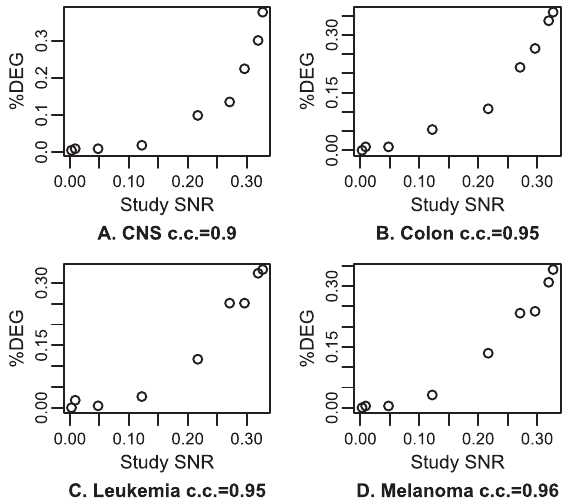
Figure 2. Effect of increasing levels of noise on study SNR and statistical significance. Statistical significance was estimated as the fraction of differentially expressed genes (%DEG). Noise was added to a study of the NCI60 on the U133A platform (GSE5720). SNR and %DEG were calculated on the modified study. Increasing noise lead to lower SNR and lower %DEG. c.c. are correlation coefficients, which underes- timate the strength of the relations as those are not linear.